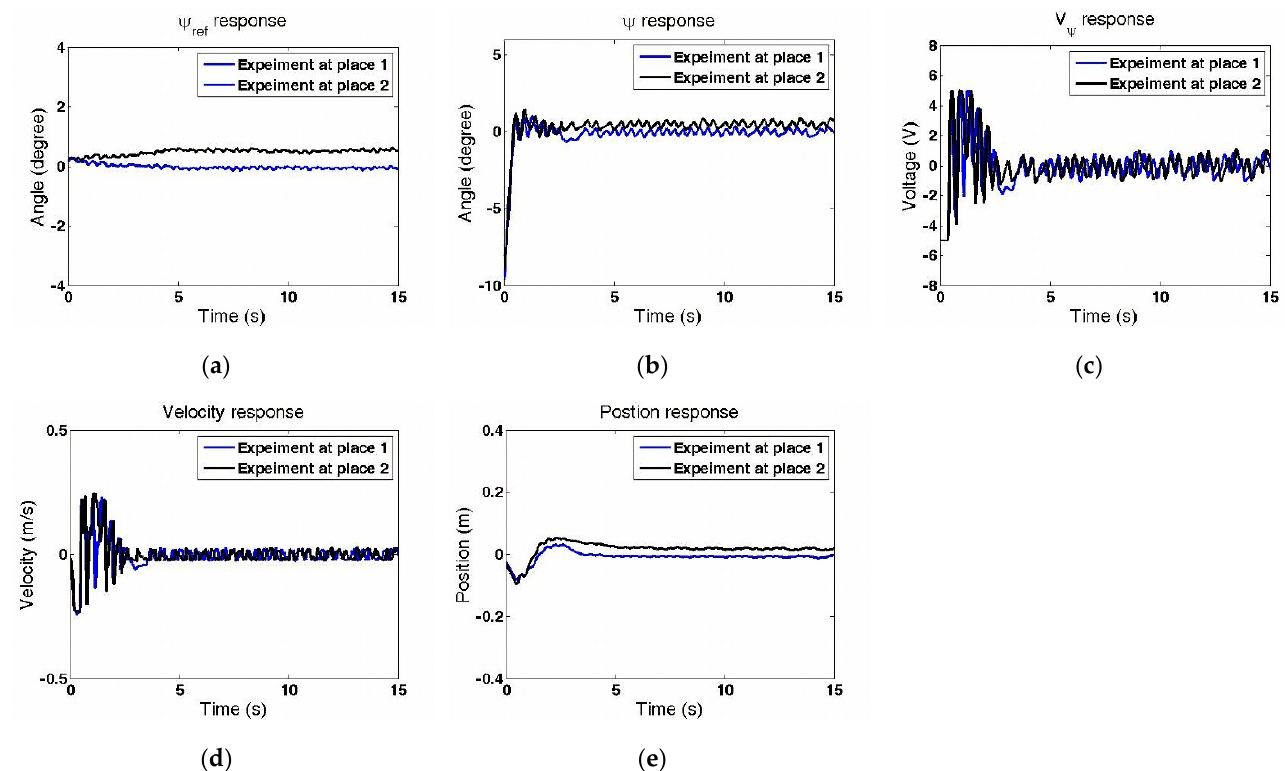
adjustment; ( b ) ( )  t responses; ( c ) control ref